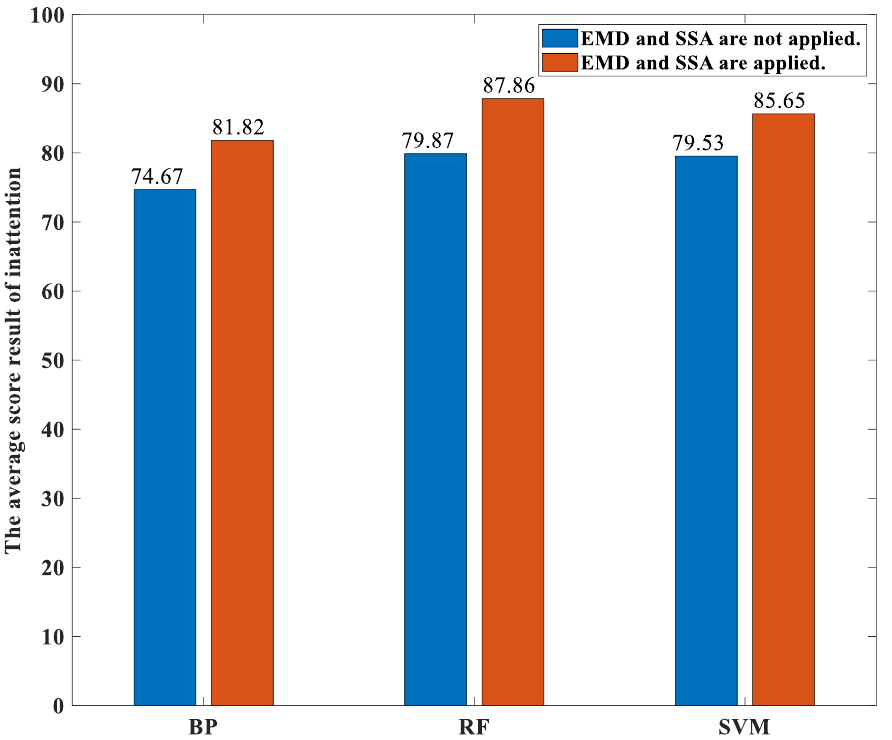
Figure 11. The average percentages of the classification accuracies over both these 12 participants performing the various activities yielded by both our proposed method and the traditional methods with different classifiers under the concentration state.